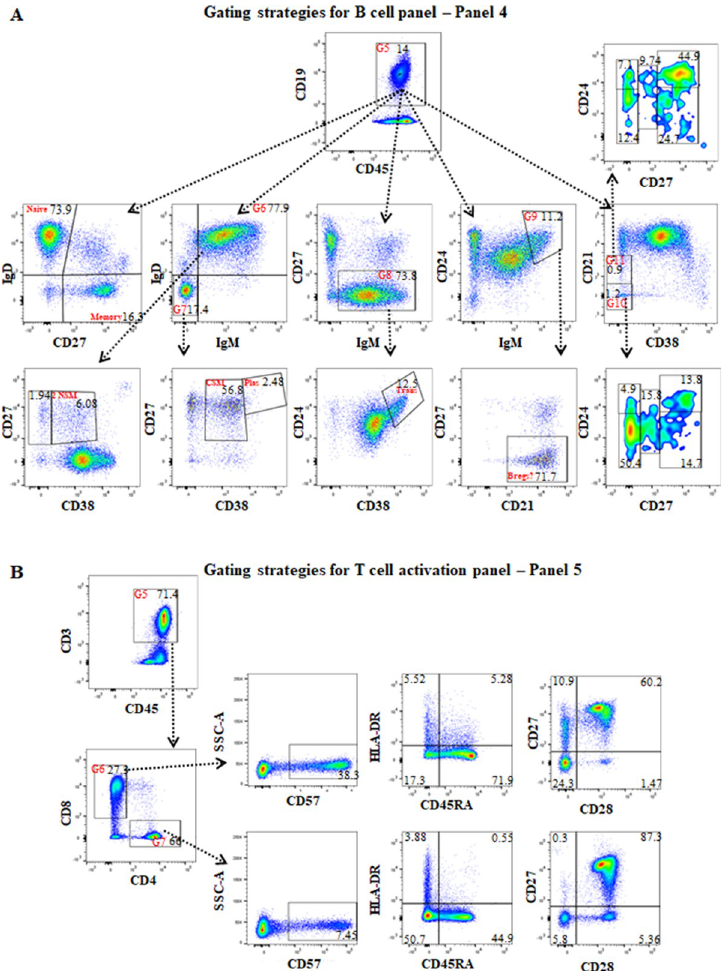
Fig 4. The gating strategies for B cell panel (panel 4) and T cell activation panel (panel 5). (A) For panel 4, the first and second gates were the same as panel 2 (Fig 3), the third gate was on lymphocytes based on FSC-A vs SSC-A, and the fourth gate was on FCS-A vs FSC-H to exclude double-cells as was done in panel 2. After gating on CD19+ B cells (G5), using CD27 and IgD expression identified IgD+CD27- na ï ve and CD27+IgD- memory B cells; after gating on IgM+IgD+ (G6), using CD38 and CD27 expression identified CD27+CD38+ and CD27+CD38- non-switched memory B cells; after gating on IgM-IgD- (G7), using CD38 and CD27 expression identified CD27+CD38+bright plasmablasts (Plas) and CD27+CD38+dim class switched memory (CSM) B cells; after gating on IgM+CD27- B cells, visualising CD38 vs CD24 identified CD24+brightCD38+bright transitional B cells (Trans); after gating on IgM +brightCD24+bright, using CD21 and CD27 expression identified CD21+CD27- B cells that may be regulatory B cells; gating on CD38-CD21- (G10) and CD38-CD21low (G11) identified innate-like or memory B cells (CD38 vs CD21) with gating using CD27 and CD24 expression for assessment of CD24+brightCD27-, CD24low/-CD27, CD27low, CD27+brightCD24+bright, and CD27+brightCD24low/- B cells. (B) For panel 5, the first and second gates were the same as in panel 2, and the third and fourth gates were the same as panel 4. After gating on CD45+CD3+ T cells (G5), CD4 vs CD8 identified the T cell subsets. Gating on CD8 T cells (G6) or CD4+ T cells (G7), comparisons of CD57 vs SS-A, CD45RA vs HLA-DR, and CD28 vs CD27 were performed for assessment of T cell activation. +CD64+ monocytes (Fig 3). In order to reduce the spillover effect, the final concentration of 0.63 μ g/ml was used rather than the concentration that produced the best SI (0.83 μ g/ml), as this was an easily identifiable population where the MFI was not analysed (Table 1). The SSM of PE-CF594-CD19 to PE-CD56 was 1.21 (S4 Table). This spillover spreading had minimal effect due to CD19+B cells and CD56+NK cells being separated on lymphocytes. Considering